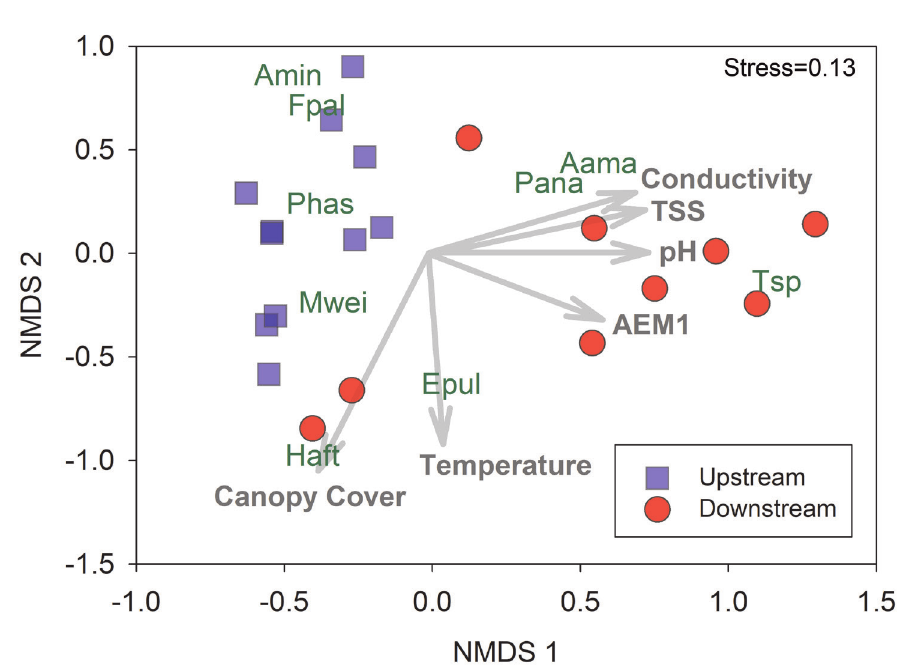
FIGURE 3 | Non-metric multidimensional scaling (NMDS) plot illustrating 20 sampling locations (points) at upstream (blue boxes) and downstream (red circles) sampling sites. Miniature fish scores are shown as green text, including Aama ( Ammoglanis amapaensis ), Amin ( Ammocryptocharax minutus ), Epul ( Elachocharax pulcher ), Fpal ( Fluviphylax palikur ), Haft ( Hemigrammus aff. tridens ), Mwei ( Microcharacidium weitzmani ), Pana ( Physopyxis ananas ), Phas ( Potamoglanis hasemani ), and Tsp ( Tyttobrycon sp.). Environmental and spatial correlates with miniature fish assemblage structure are shown as gray vectors and text, including water overhead canopy cover (%), water temperature (C), pH, total suspended solids (TSS, ppm), conductivity (µs/cm), and the spatial relationship among sites from the first axis of an asymmetric eigenvector map